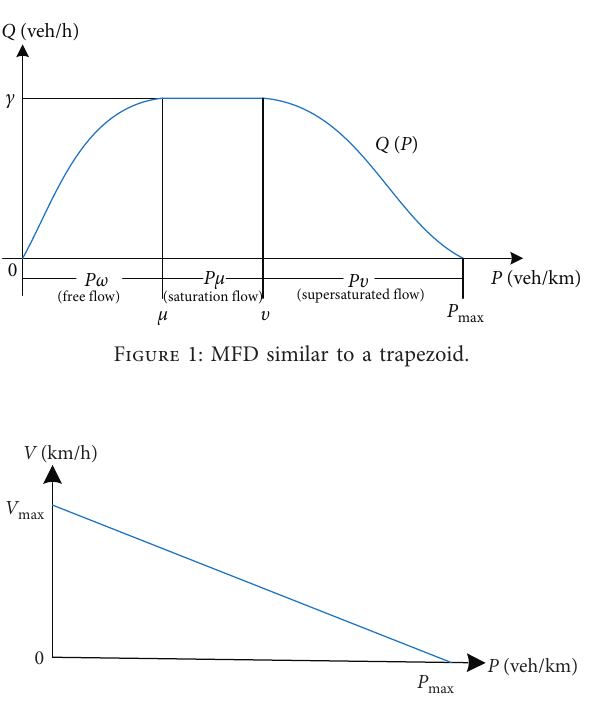
Figure 2: Relationship between vehicle average speed and traffic flow